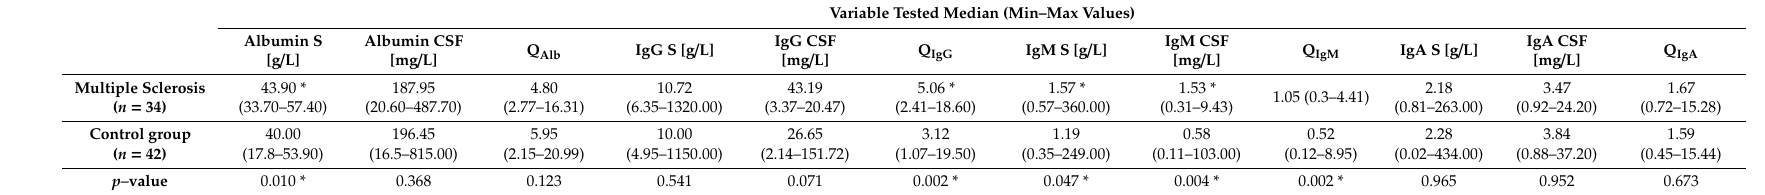
Table 1. Results of laboratory tests for patients with multiple sclerosis and the control